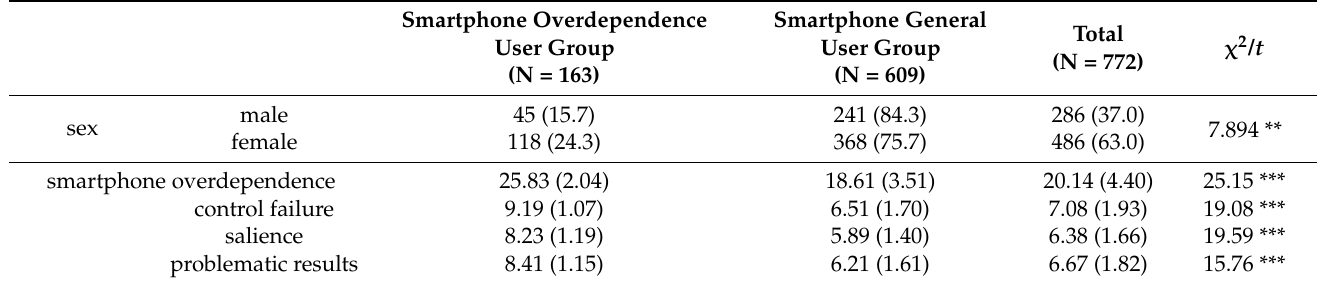
Table 1. A comparison of measurements of the aspects of smartphone overdependence (Smart Rest Center, 2022) in the smartphone overdependence group and the general user group.